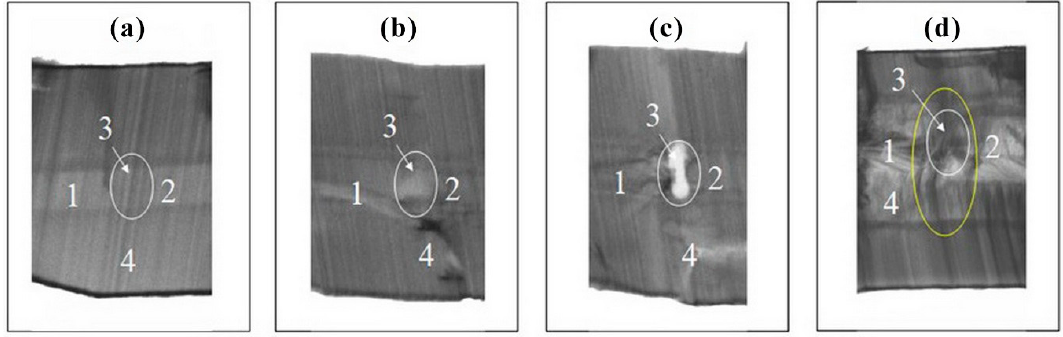
Figure 8. X-ray topography of cross sections of GaPO 4 crystals grown on c {0001} seed plates (thickness is near to 1.5 mm) included some defects: ( a ) twin, ( b ) dislocation, ( c ) crack and ( d ) all together. 1, 2—initial seed plates; 3—defect (twin, dislocation or crack), 4—overgrown layer.